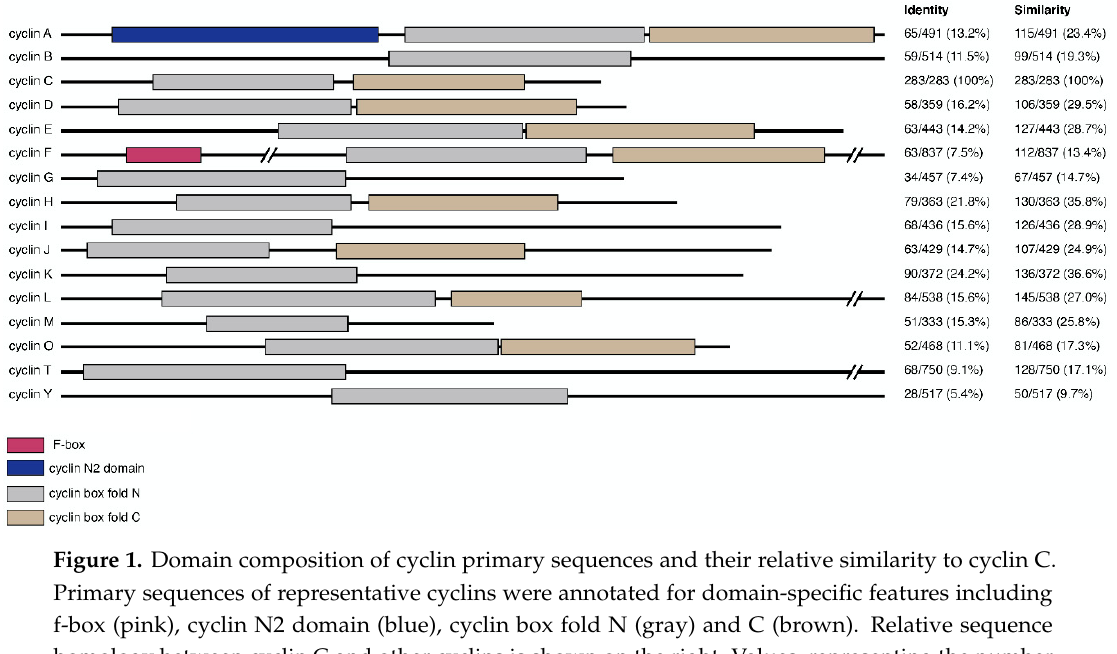
Figure 1. Domain composition of cyclin primary sequences and their relative similarity to cyclin C. Primary sequences of representative cyclins were annotated for domain-specific features including f-box (pink), cyclin N2 domain (blue), cyclin box fold N (gray) and C (brown). Relative sequence homology between cyclin C and other cyclins is shown on the right. Values, representing the number of identical or similar amino acid residues divided by the total protein length, were generated using EMBOSS Needle and expressed as percentages